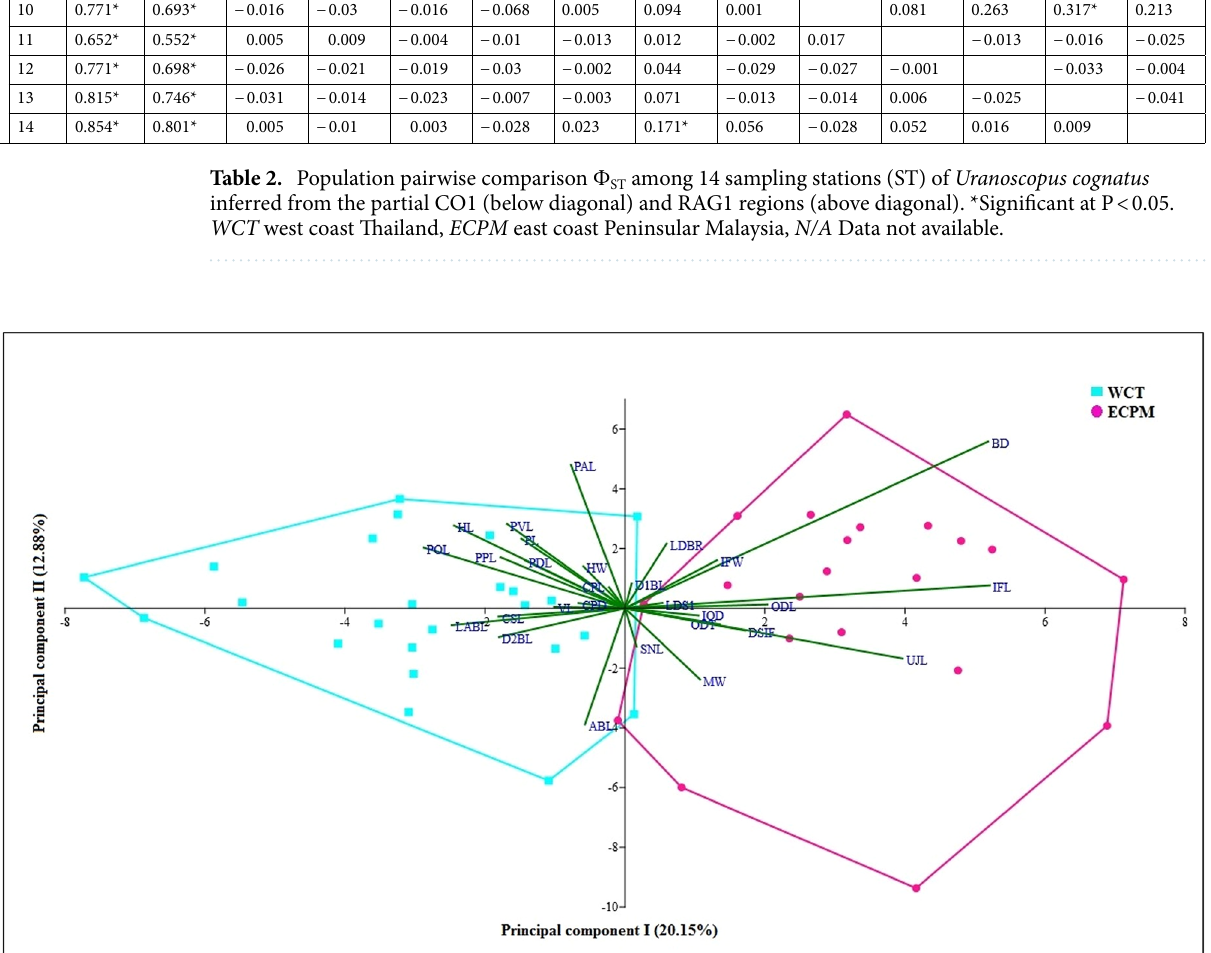
Figure 4. Principal component analysis depicting the first two axes of morphological variation of Uranoscopus cognatus from the west coast Thailand (WCT) (n = 24) and the east coast Peninsular Malaysia (ECPM) (n = 21), created in PAST v3.24 (http:// priede. bf. lu. lv/ ftp/ pub/ TIS/ datu_ anali ize/ PAST/2. 17c/ downl oad.